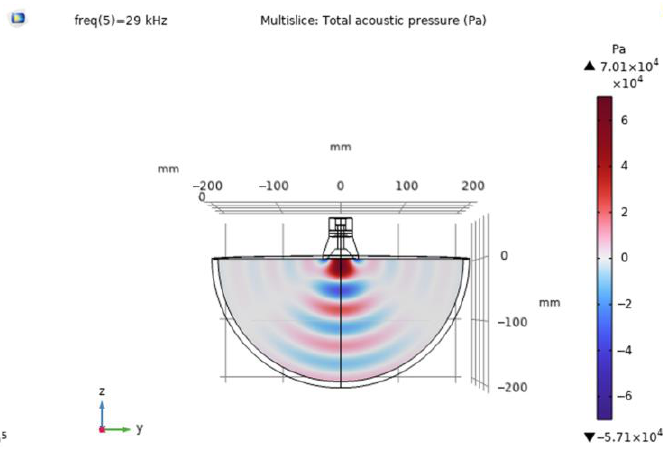
Figure 6. Modal shapes of the piezoelectric transducer at the second natural frequency vibrations: ( a ) with flat surface; ( b ) with 58 mm diameter ring-shaped surface; ( c ) with 100 mm diameter ring-shaped surface.